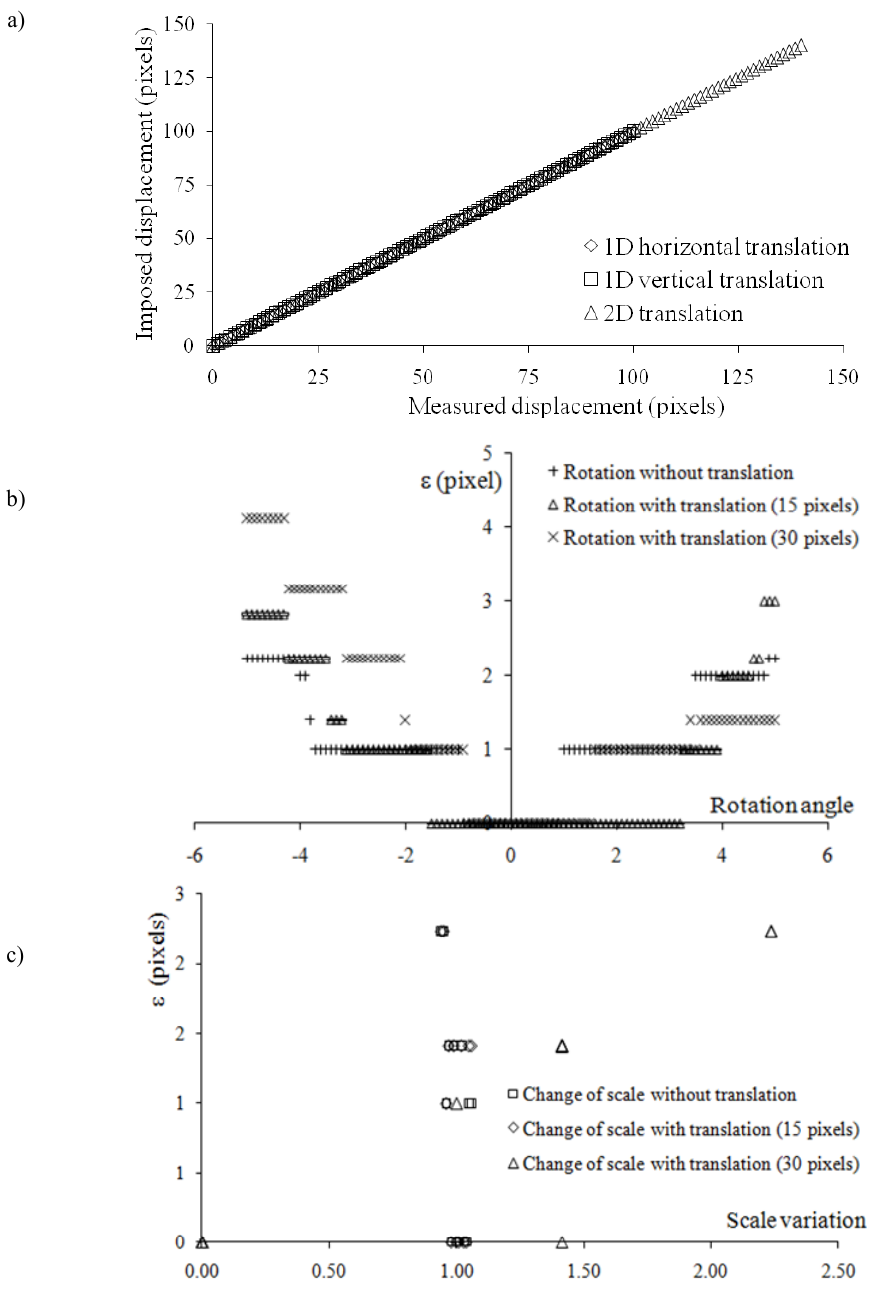
Figure 7. Comparison of imposed and measured